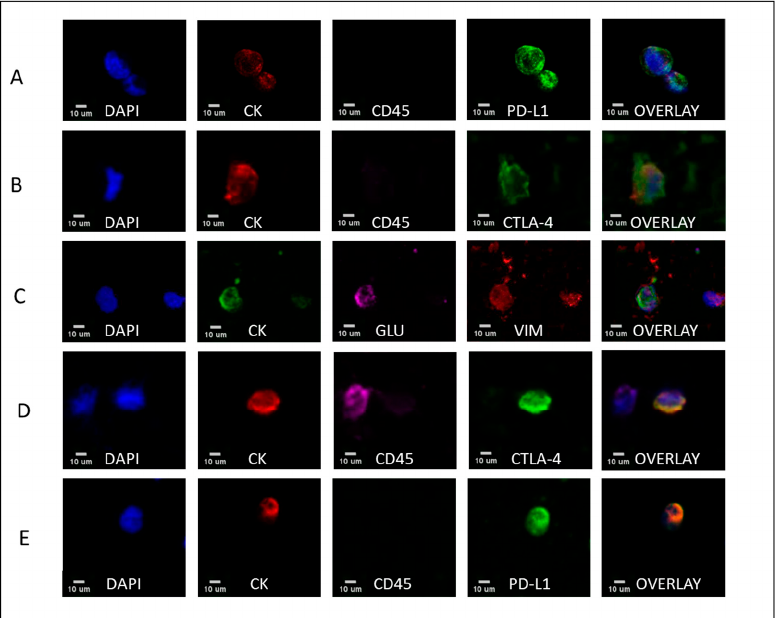
Figure 3. PD-L1, CTLA-4, GLU, and VIM expression in TNBC and luminal patients’ CTCs. The first column represents nuclei stained with DAPI, the second column represents cells expressing CK, the third cells expressing CD45 and GLU, the fourth cells expressing either PD-L1, CTLA-4, or VIM, while the fifth represents the overlay of the four channels. Representative panels of TNBC CTCs with ( A ) expression of PD-L1; ( B ) CTLA-4; and ( C ) expression of GLU and VIM. ( D ) Expression of CTLA-4 and ( E ) PD-L1 in luminal patients’ samples. Scale bars = 10 μ m.